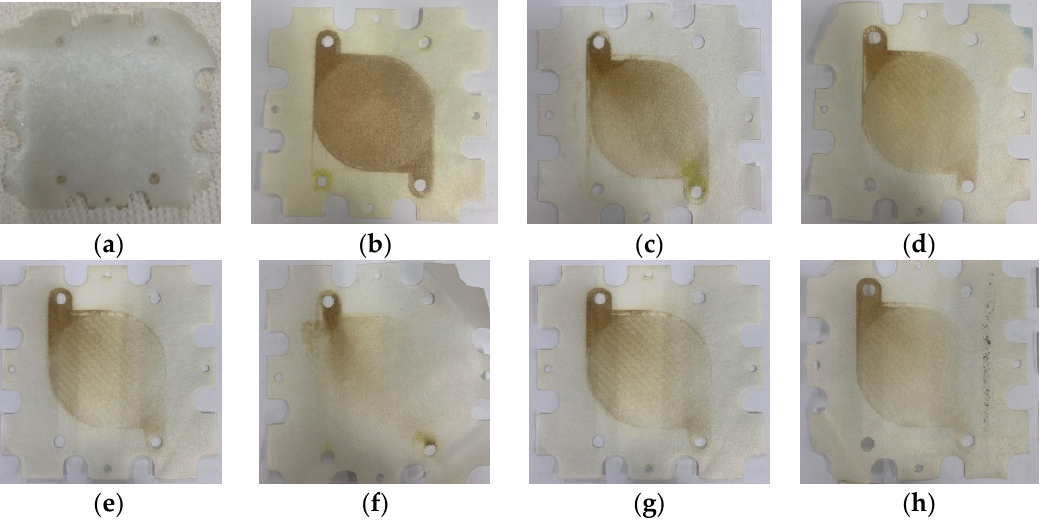
Figure 8. Visual observation of AEMs: ( a ) pristine AEM; ( b ) AEM using WWBR; ( c ) AEM using WWBR pretreated by CF; ( d ) AEM using WWBR pretreated by MF; ( e ) AEM using WWBR pretreated by UF; ( f ) AEM using WWBR pretreated by NF; ( g ) AEM after the use of AFM; and ( h ) AEM after the use of GAC.